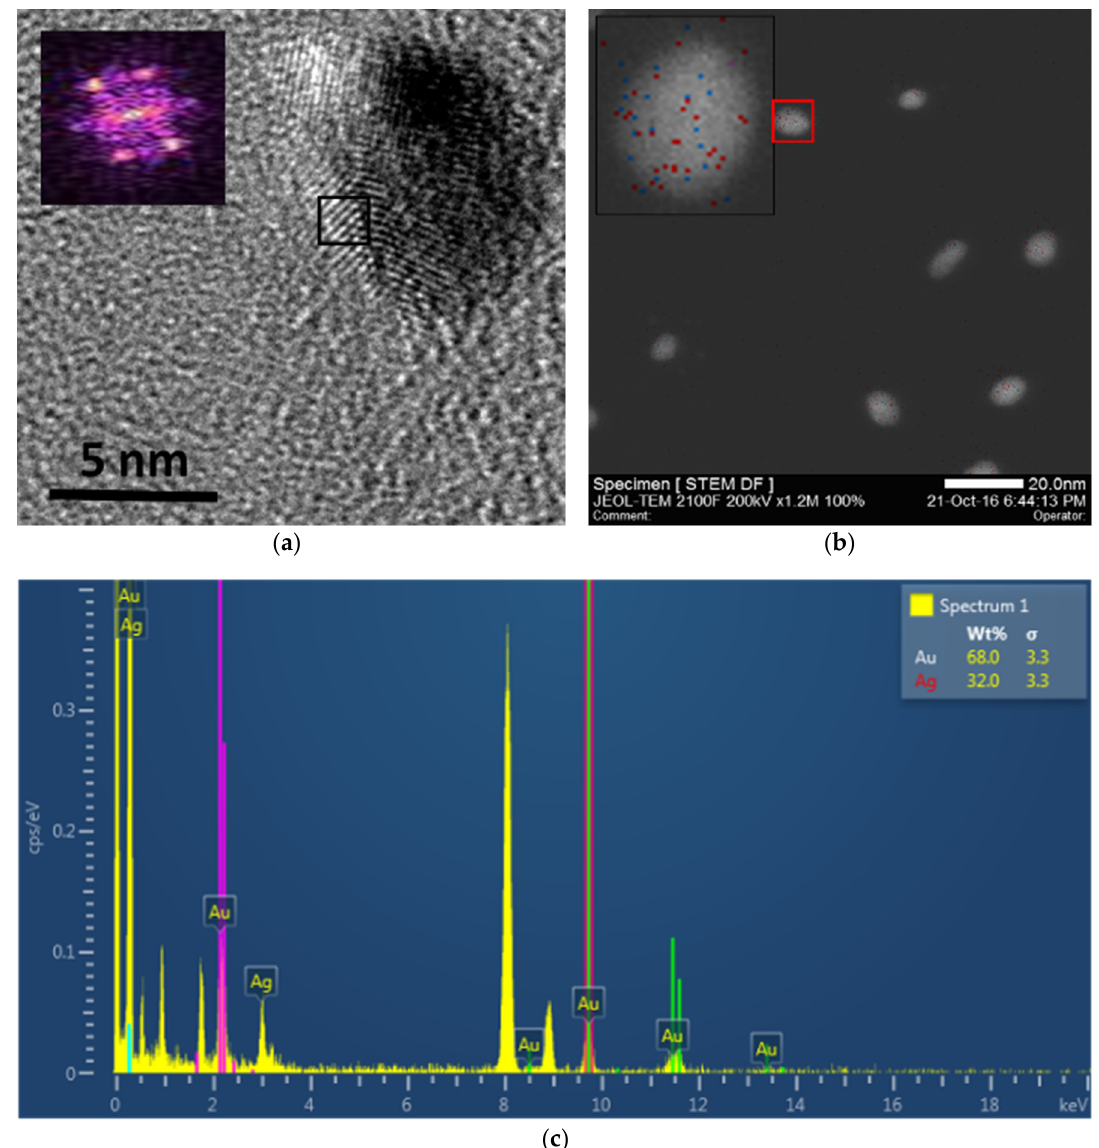
Figure 4. ( a ) HRTEM and ( b ) HRSTEM images of bimetallic AuAg SPNPs. Inset in Figure 4a displays the FFT pattern of the crystal lattice inside the black square. Inset in Figure 4b shows the EDX elemental mapping of the bimetallic SPNP inside the red square. ( c ) EDX elemental analysis of the bimetallic SPNP inside the red square.